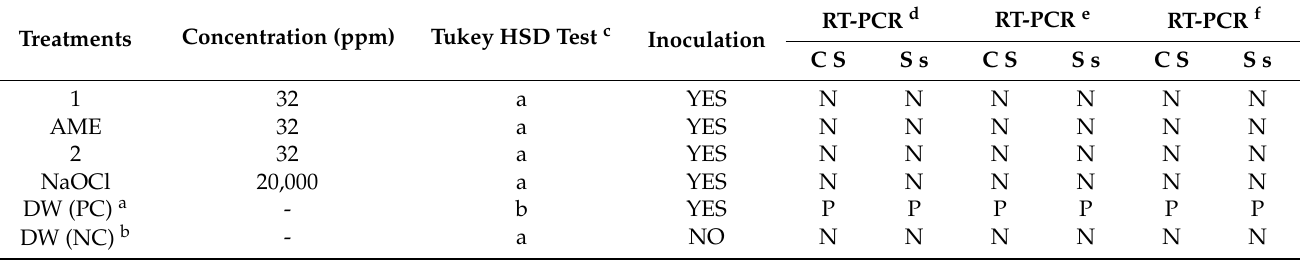
Table 1. Qualitative evaluation of the presence of ToBRFV during the antiviral activity assay.